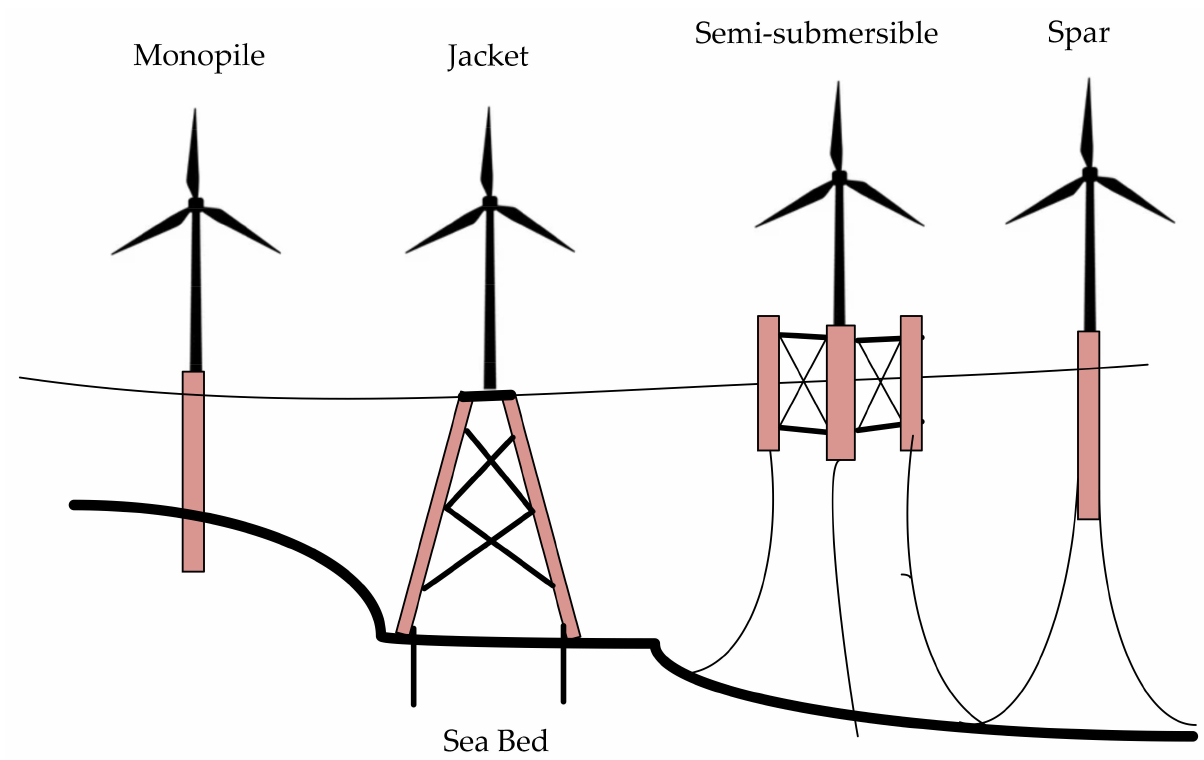
Figure 1. Wind-turbine foundation-types in different water